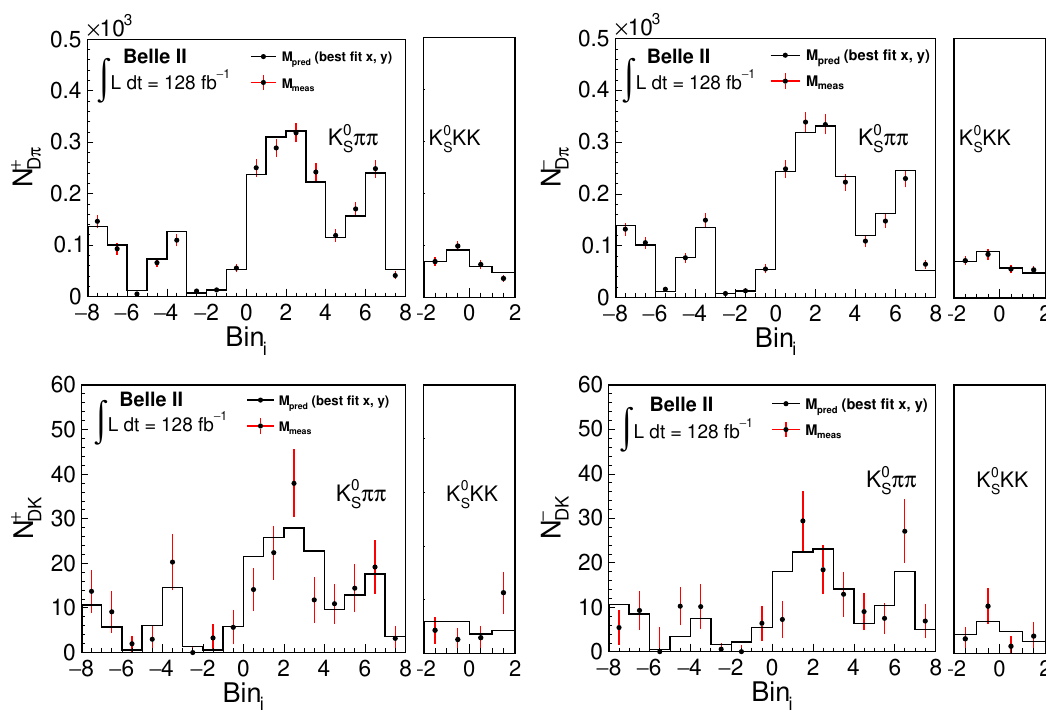
Figure 7 . Yields in bins for B + → Dπ + (top left), B − → Dπ − (top right), B + → DK + (bottom left) and B − → DK − (bottom right) decays in the Belle II data set. The data points with error bars are the measured yields with their statistical uncertainty and the histogram is the expected yield from the best fit ( x ) parameter values. ± , y ±